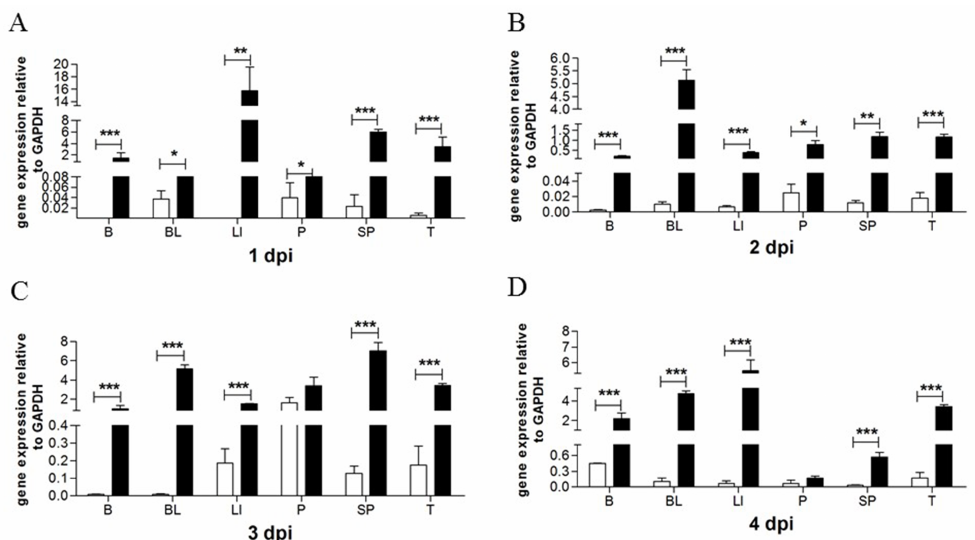
Figure 2. Tissue-specific mRNA of goMx in TMUV-infected goslings. The white columns are for control groups, while the black columns stand for test groups. Goslings were infected with TMUV (1 µ L volume of TMUV per gram of the body weight), then tissues were collected, including brains (B), blood (BL), liver (LI), pancreas (P), spleen (SP), and thymus (T). GoMx transcript detection at one day ( A ), two days post infection ( B ), three days ( C ) and four days ( D ) post infection. GAPDH was employed as an internal reference. Asterisks (*) mark the significant difference between experimental and control groups (* p < 0.05; ** p < 0.01; *** p < 0.001). Error bars indicate standard